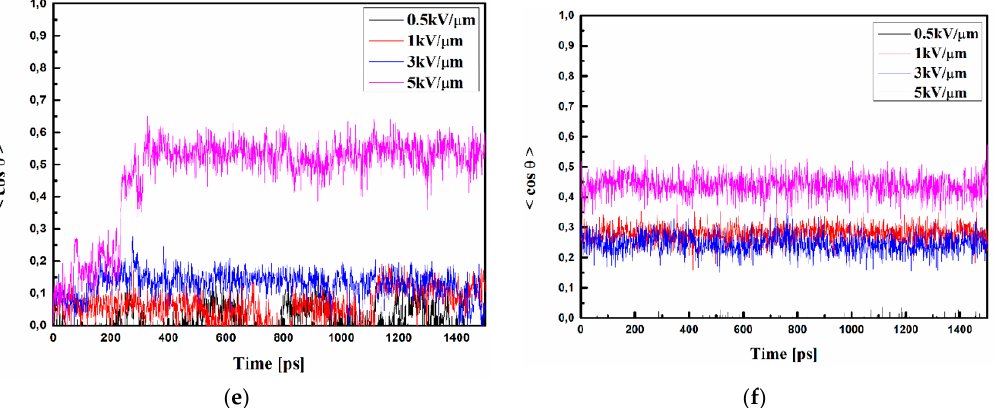
Figure 10. Changes in the value of the order parameter < cos θ ( t ) > versus the time of simulation and applied external electric field calculated by MD technique for the A / PVK ( a , b ), B / PVK ( c , d ), and C / PVK ( e , f ) composites in the thin film form at the temperature of 500 K ( a , c , e ) and glassy state (300 K) after the simulated annealing ( b , d , f ).